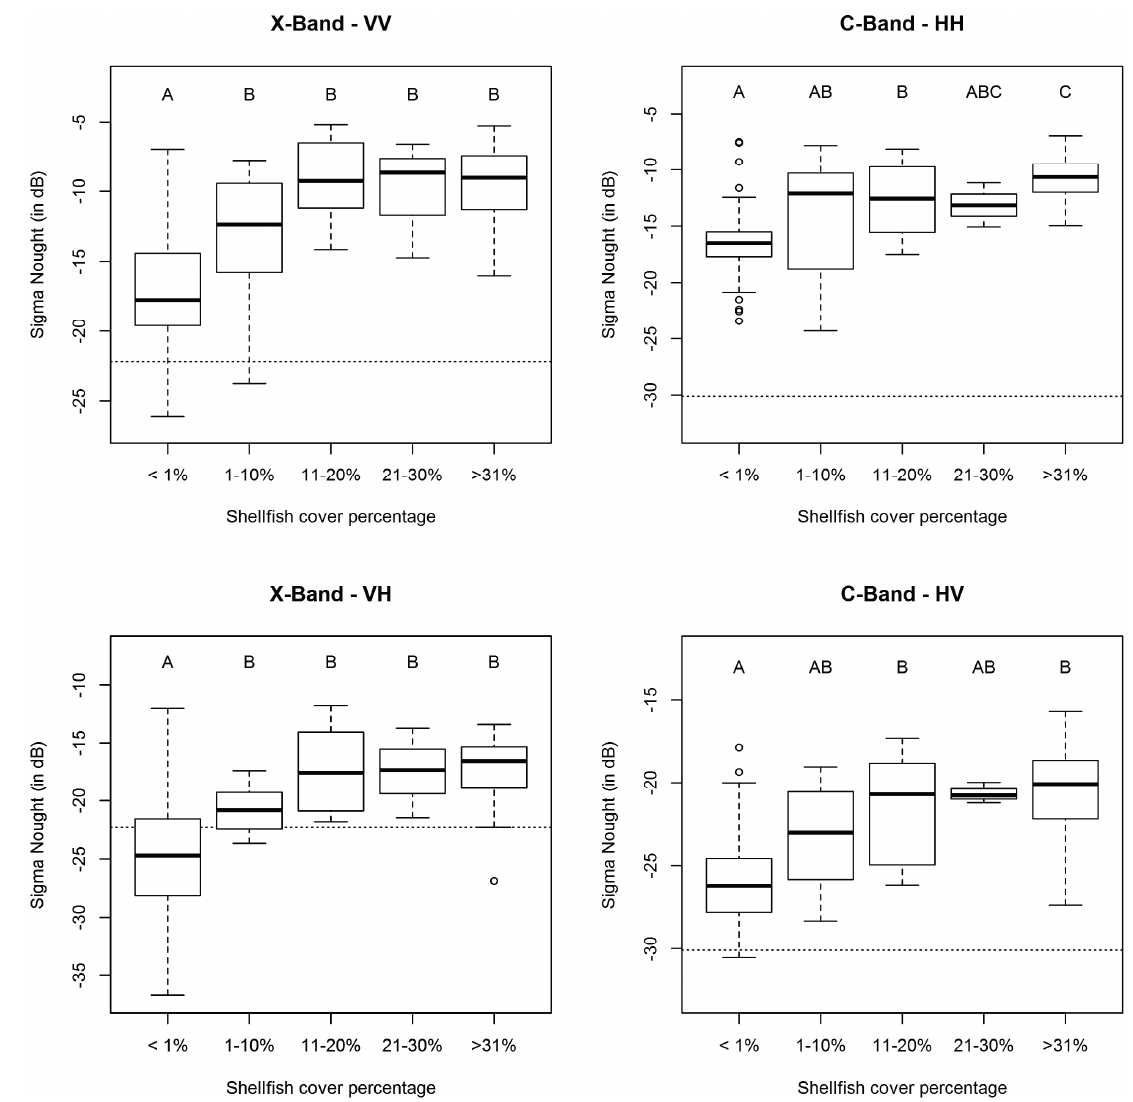
Figure 6. Boxplots showing the relationship between radar backscatter and shellfish cover. Letter codes indicate similarity based on the Tukey HSD test. The dashed line indicates the average noise floor (noise equivalent sigma